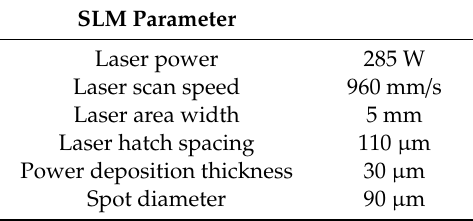
Figure 3. The porous test specimens manufactured by SLM are shown ( a ) and the internal structure of the test specimens ( b ) [27]. Table 2. Selective laser melting (SLM) parameters used to produce porous tensile test specimens for mechanical testing.